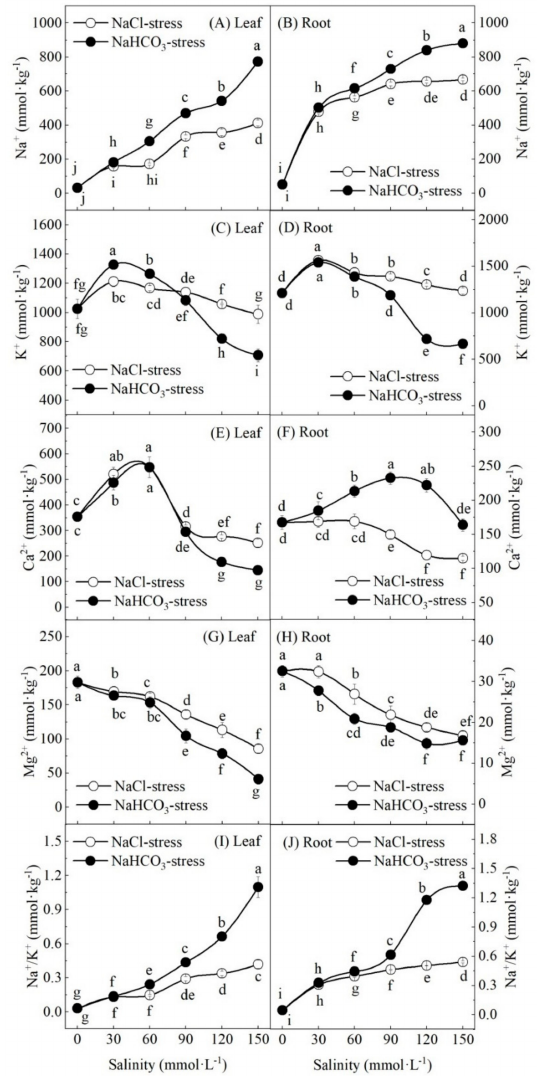
Figure 4. E ff ects of NaCl and NaHCO 3 stresses on the Na + ( A , B ), K + ( C , D ), Ca 2 + ( E , F ), Mg 2 + ( G , H ) concentrations, and Na + / K + ( I , J ) in leaves and roots of the common bean ( Phaseolus vulgaris ). Common beans were treated with NaCl (30–150 mmol · L − 1 , pH 6.65–6.86) and NaHCO 3 (30–150 mmol · L − 1 , pH 8.17–8.27) stresses. Data points and bars represent the mean ± SD of three replicates. Values followed by di ff erent letters in the same subgraph are significantly di ff erent at the 5% level among the various concentration treatments of neutral salt conditions or alkaline salt conditions, according to Duncan’s new multiple range